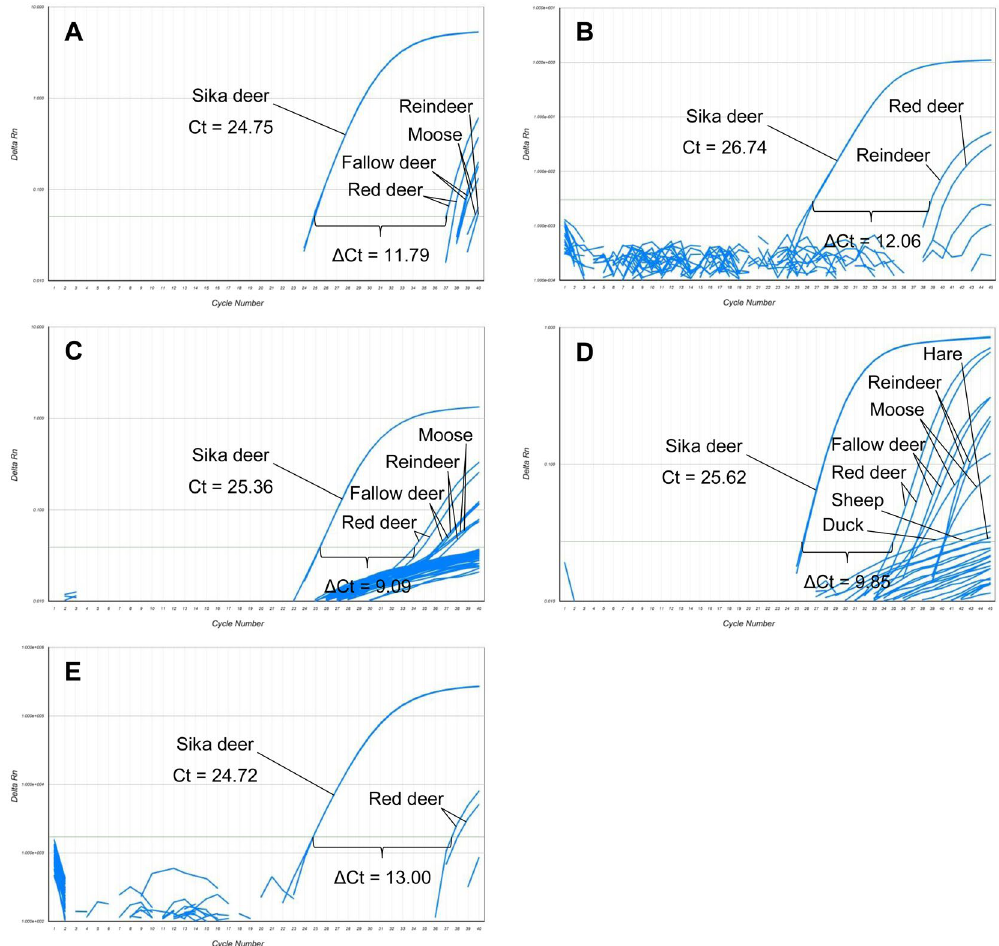
Figure 2. Results obtained in cross-reactivity tests performed with DNA isolates from 23 animal species with 5 commercial master mixes. ( A ) QuantiTect ® Multiplex PCR NoROX Master Mix (Qiagen), ( B ) TaqMan